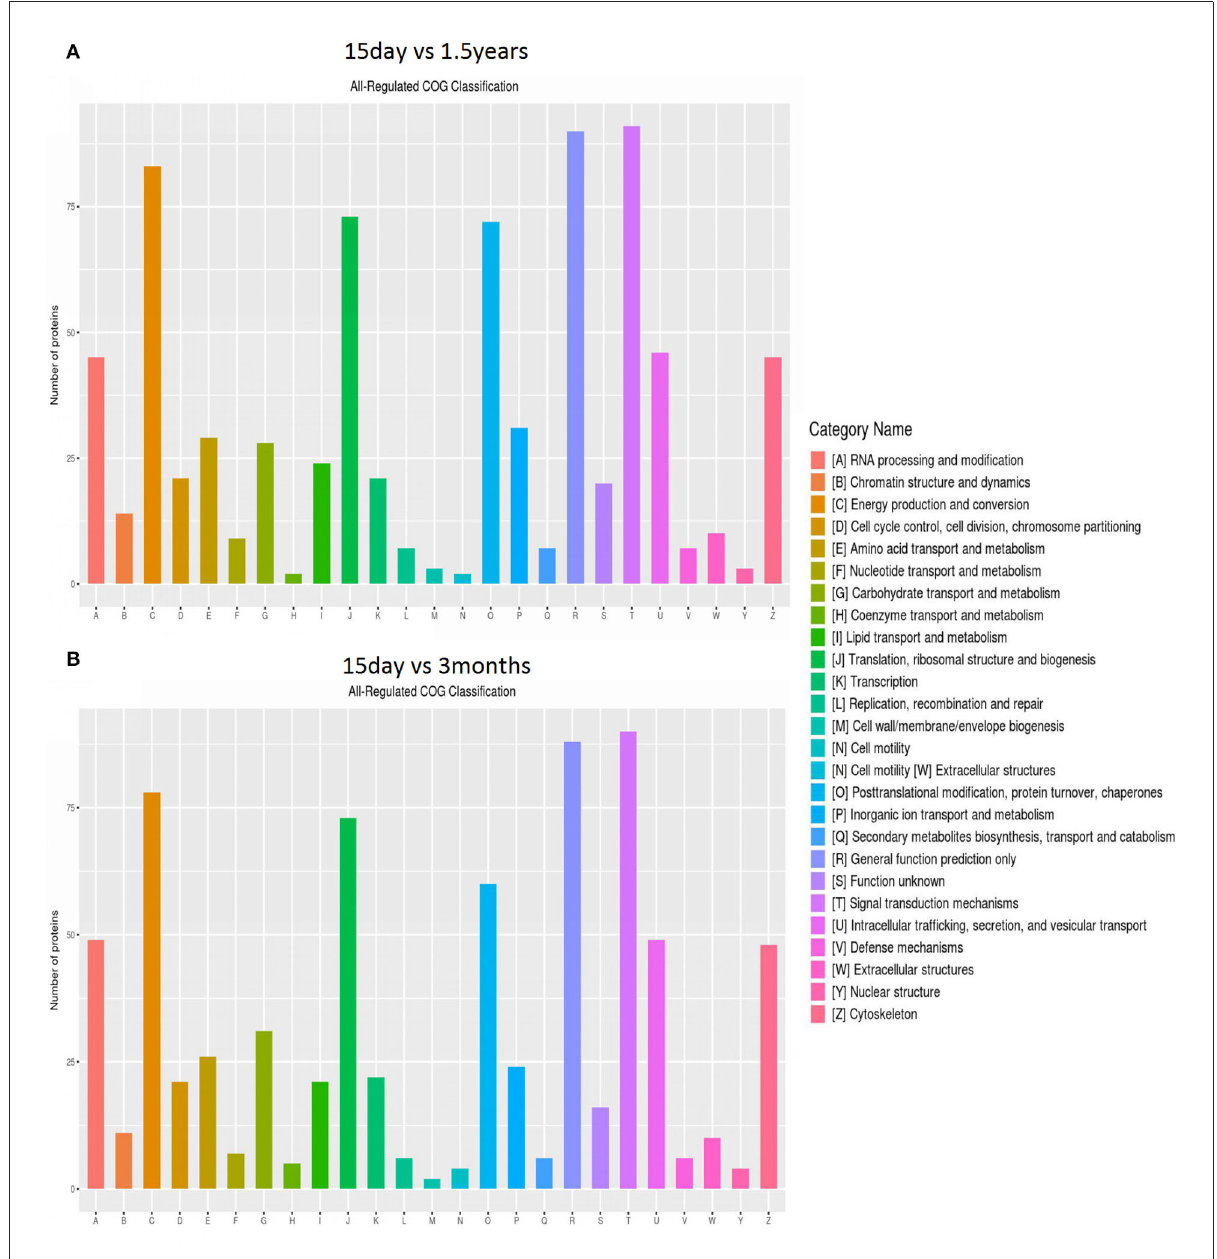
FIGURE3 Clusters of orthologous genes (COG) enrichment analysis. The vertical axis represents the number of enriched proteins, and the horizontal axis is an enrichment function entry. (A) Functional enrichment of differentially expressed proteins in the 15-day and 1.5-year age groups, and (B) functional enrichment of differentially expressed proteins in the 15-day and 3-month age groups.